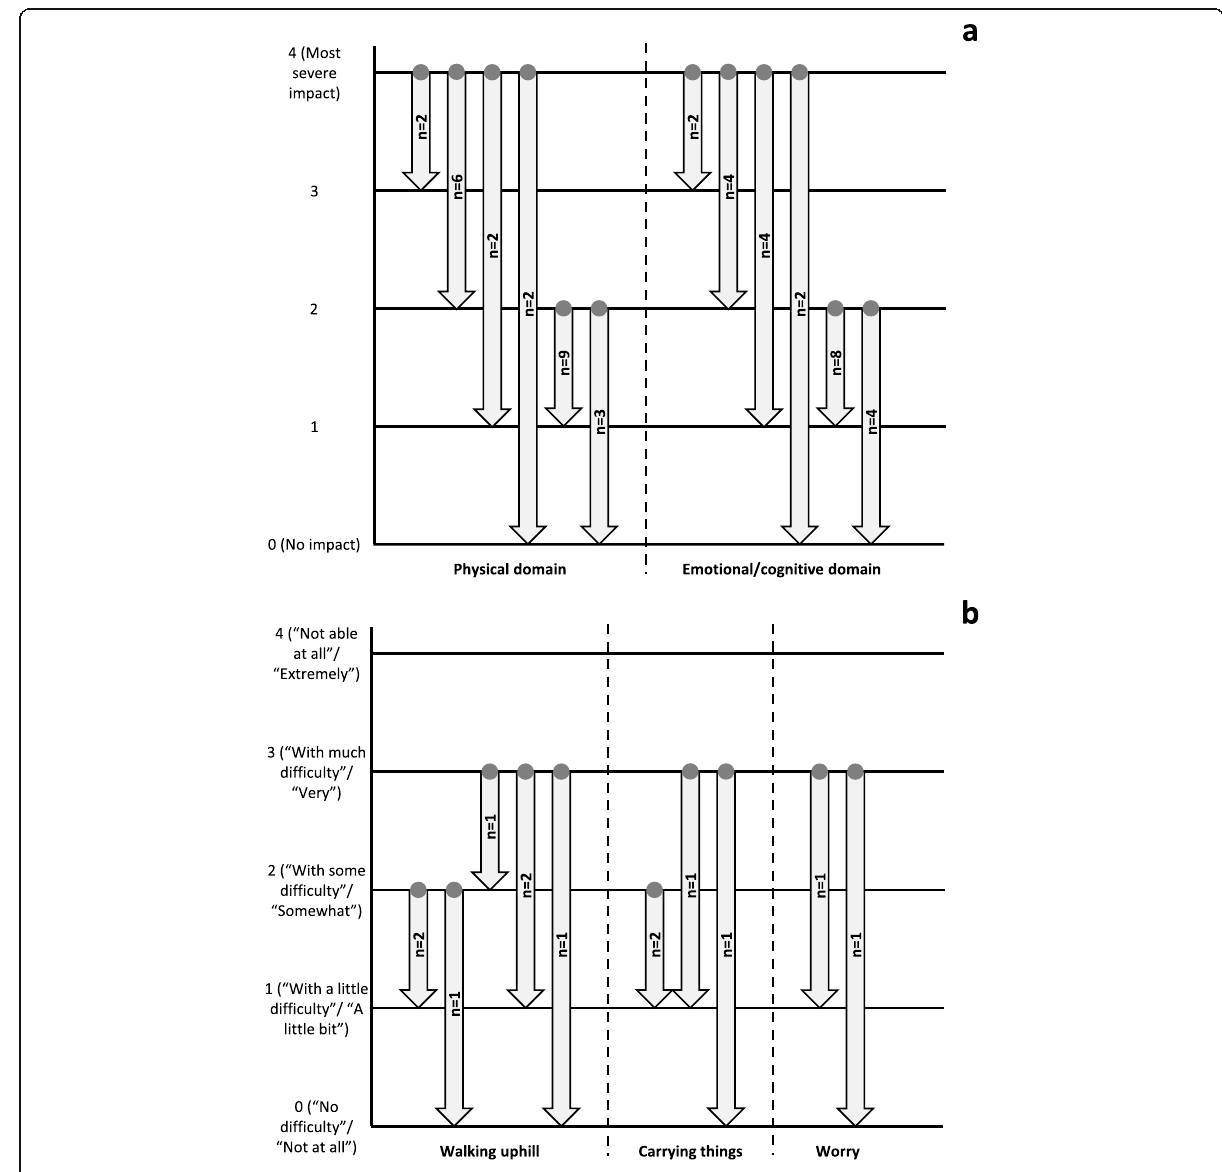
Fig. 2 Meaningful change for impacts. a Impact domains. b Individual impact items. The starting point when discussing meaningful change (denoted by the dots at the base of the arrows) was a hypothetical severity level of 4 or 2 for the impact domains; for the impact items, the starting point was the response given when completing the PAH-SYMPACT ™ . For each impact item, only participants who scored the item as 2 or higher when completing the PAH-SYMPACT ™ were included in the meaningful change discussions. Physical domain: walking slowly on a flat surface, walking quickly on a flat surface, walking uphill, carrying things, doing light indoor household chores, washing or dressing oneself, and needing help from others; emotional/cognitive domain: thinking clearly, feeling sad, feeling worried, and feeling